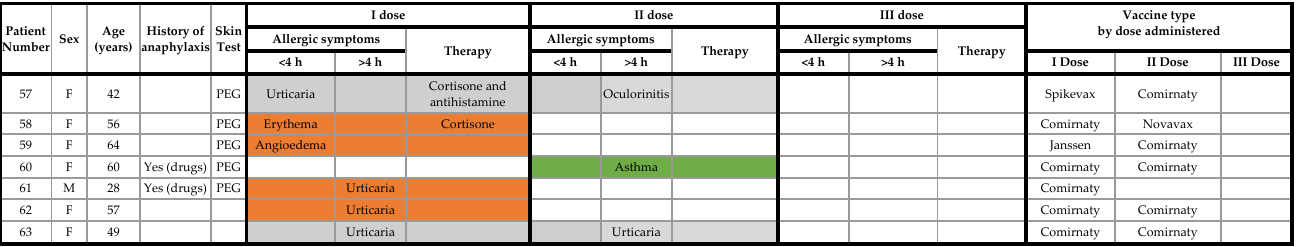
Reactions only to dose I (orange): N = 29. Reactions to doses I and II (grey): N = 17. Reactions only to dose II (green): N = 11. Reactions to doses II and III (pink): N = 2. Reactions only to dose III (yellow): N = 3. Reactions to doses I and III (purple): N = 1. Table 3. Allergic reactions to COVID-19 vaccination, reported by high-risk allergic patients of ASUGI Trieste. M = males; F = females. Table 4 reports the aggregated adverse and allergic reactions to different COVID-19 vaccines in the general population of the Trieste – Gorizia catchment area, according to the dose administered. The overall prevalence of allergic reactions was 0.047% (=333/706,573 doses administered in 2021) and only eight vaccinees were recorded in the Italian national surveillance system for adverse vaccine events. No cases of anaphylaxis occurred, and reactions included urticarial, angioedema, itching, asthma and rhinitis events. Thirty- three cases were classified as “severe reactions” requiring treatment and medical support. Considering only official data, the prevalence of allergic reactions was significantly higher ( p < 0.001) in vaccinated patients with a history of severe allergy (3.8% = 8/208) compared to that in COVID-19 vaccinees from the general population (0.047%). Table 4. COVID-19 vaccines administered in the general population of ASUGI (Trieste – Gorizia catchment area) and adverse reactions reported by 31 December 2021. Number (N) and percentage of adverse reactions out of total vaccine doses.